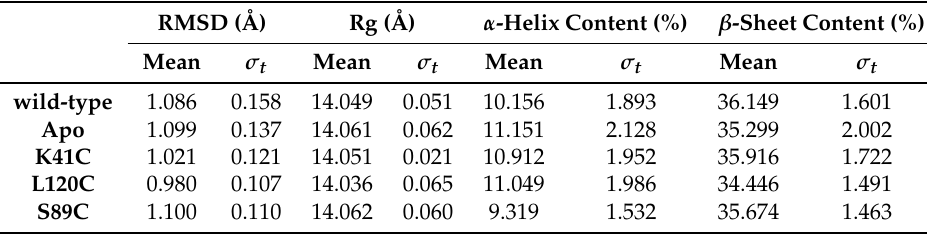
Table 1. Mean and standard deviation values of the: RMSD, Rg, α -helix and β -sheet content in the last 200 ns of MD